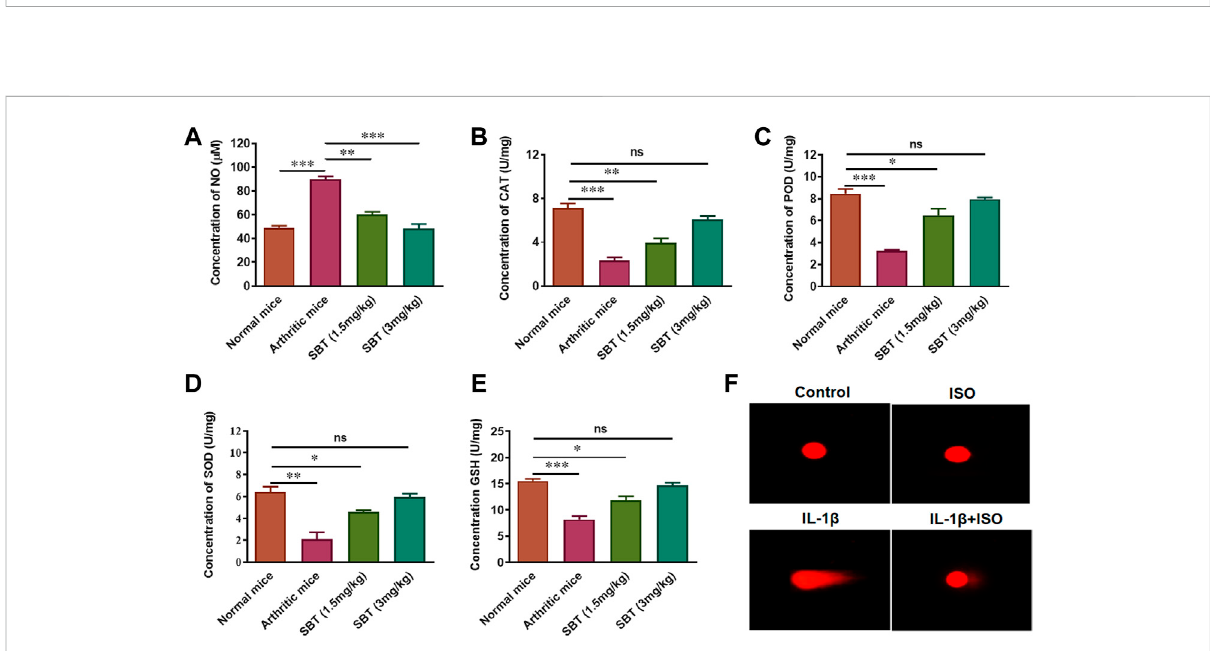
FIGURE 5 Antioxidant enzyme analysis in vitro and in vivo . Mice ( n = 4) from each experimental group were slaughtered at day 28 and cartilage homogenates were isolated. These cartilage homogenates were subjected to centrifugation and the serum was analyzed to determine the concentration of NO (A) , CAT (B) , POD (C) , SOD (D) and GSH (E) . (F) Comet Assay. Cells were collected after 3 h ’ treatment with Control, ISO, IL-1 β and IL-1 β +ISO and run on 1% agarose gel. The assessment of nuclear fragmentation of CHON-001 cells was performed. Images (200×) were analyzed by using CASPLAB. * p < 0.05, ** p < 0.01, *** p < 0.001, ns, not signi fi